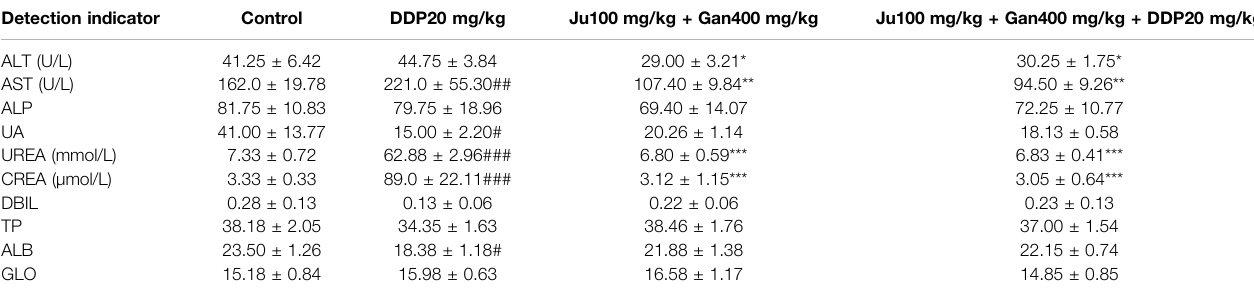
TABLE 7 | Blood biochemical analysis. Detection